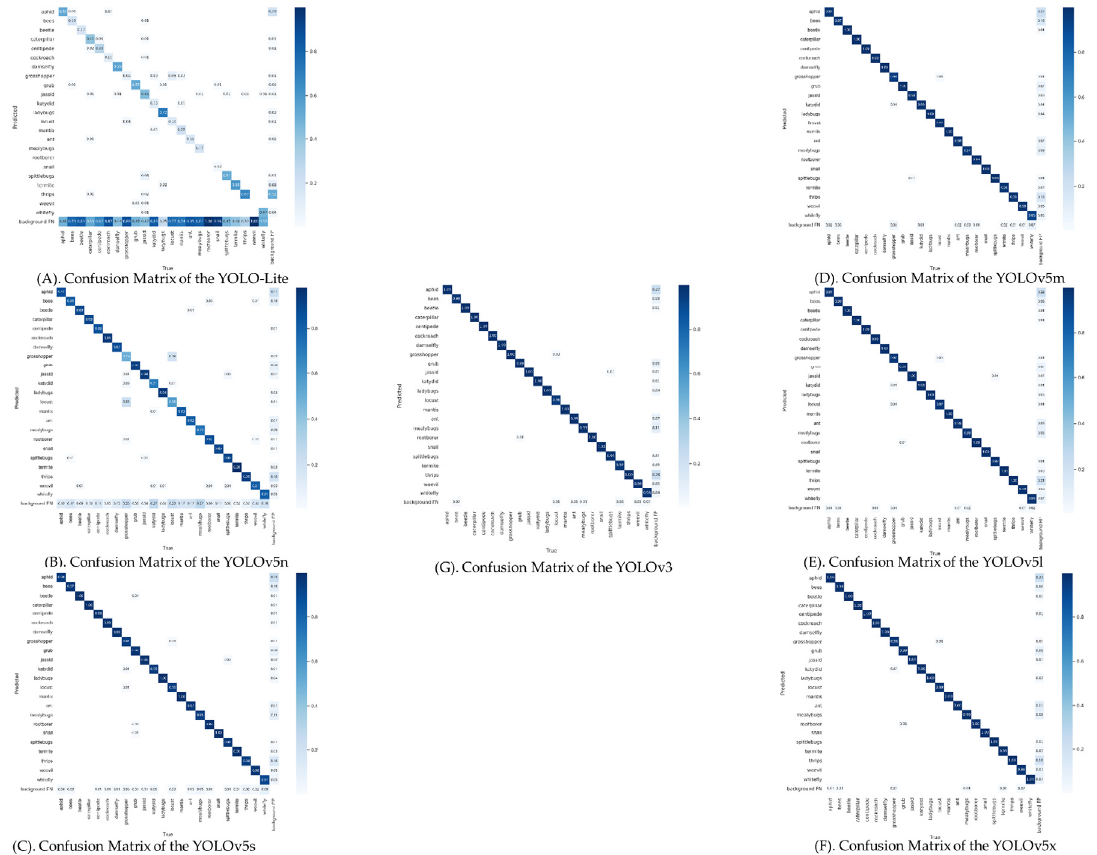
Figure 10. Confusion Matrix of ( A ) YOLO-Lite ( B ) YOLOv5n ( C ) YOLOv5s ( D ) YOLOv5m ( E ) YOLOv5l ( F ) YOLOv5x ( G )